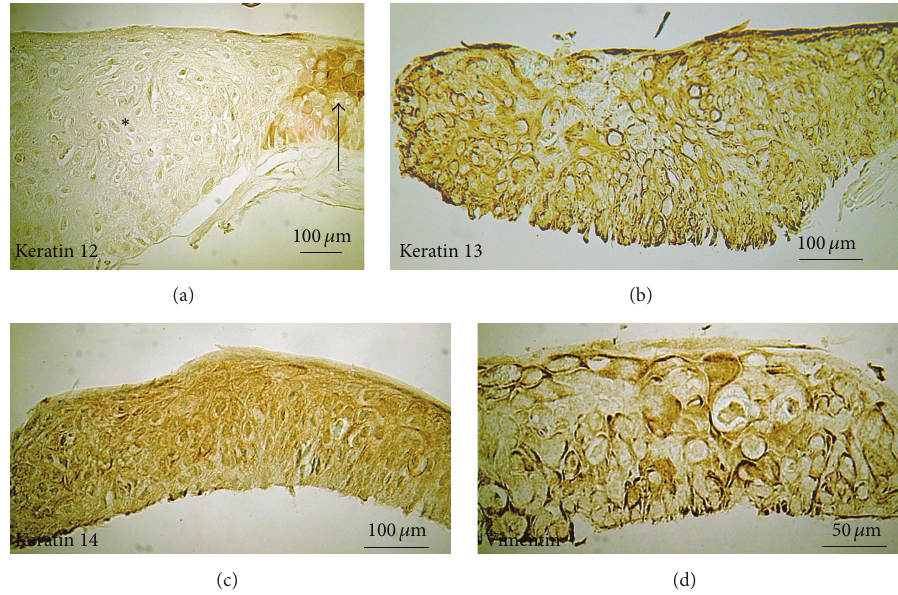
Figure 4: Immunohistochemical detection of intermediate filament components in dysplastic epithelium. Keratin 12 (a) is not expressed in dysplastic epithelial cells (asterisk), while it is well detected in normal corneal epithelium (arrow) adjacent to the lesion. Keratin 13 (b) and keratin 14 (c) are readily detected in the dysplastic cells throughout the layers. Some of the dysplastic cells are labeled for vimentin